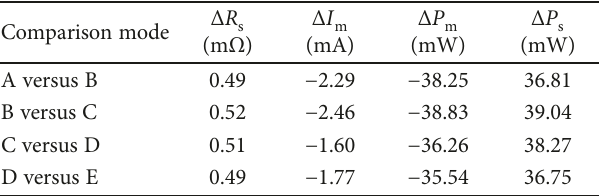
Figure 10: Sketch of the module electrode structure and test mode used to analyze the in fl uence of the series resistance variation on P m . Δ I Δ P Δ P Table 1: Δ R s , m , m , and s between adjacent two points: Δ I Δ P – V tester; Δ P Δ R s , m , and m were tested by I s was calculated with (12).